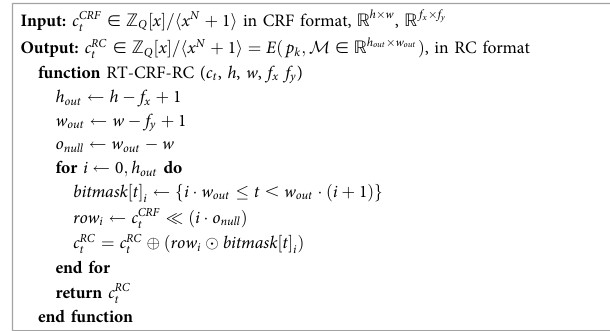
Algorithm 12 Result Transformation CRF to